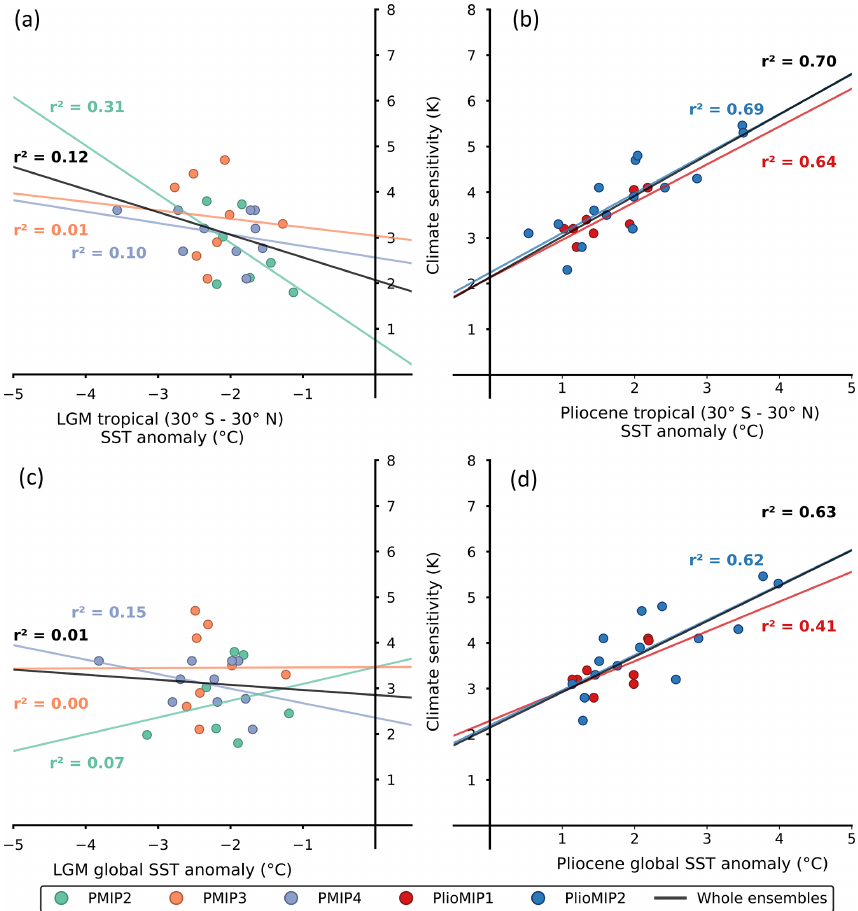
Figure 1. Emergent constraints for the LGM (a) tropical and (c) global SST anomaly and the ECS of PMIP2, PMIP3 and PMIP4 models. Emergent constraints for the Pliocene (b) tropical and (d) global SST anomaly from PlioMIP1 and PlioMIP2 models. Ordinary least squares regression is calculated, and the coefficients of determination r 2 from each sub-ensemble is shown to illustrate the quality of the regression. For the LGM, CESM2.1 is filtered out as discussed in Sect.